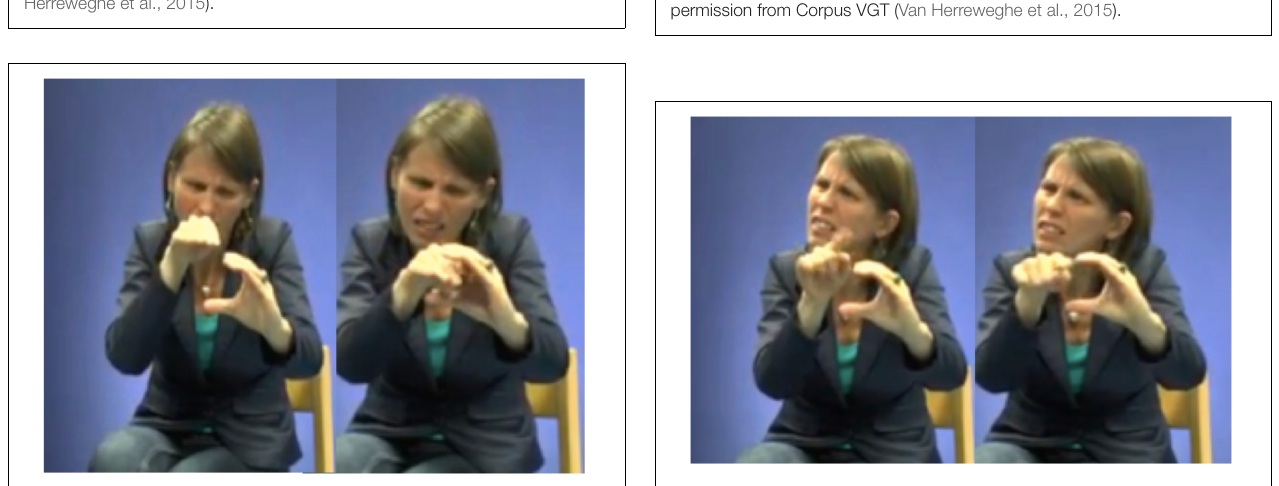
FIGURE 12 | PS a – pointing sign that traces the shape of the molehill. Figure reproduced with permission from Corpus VGT (Van Herreweghe et al.,